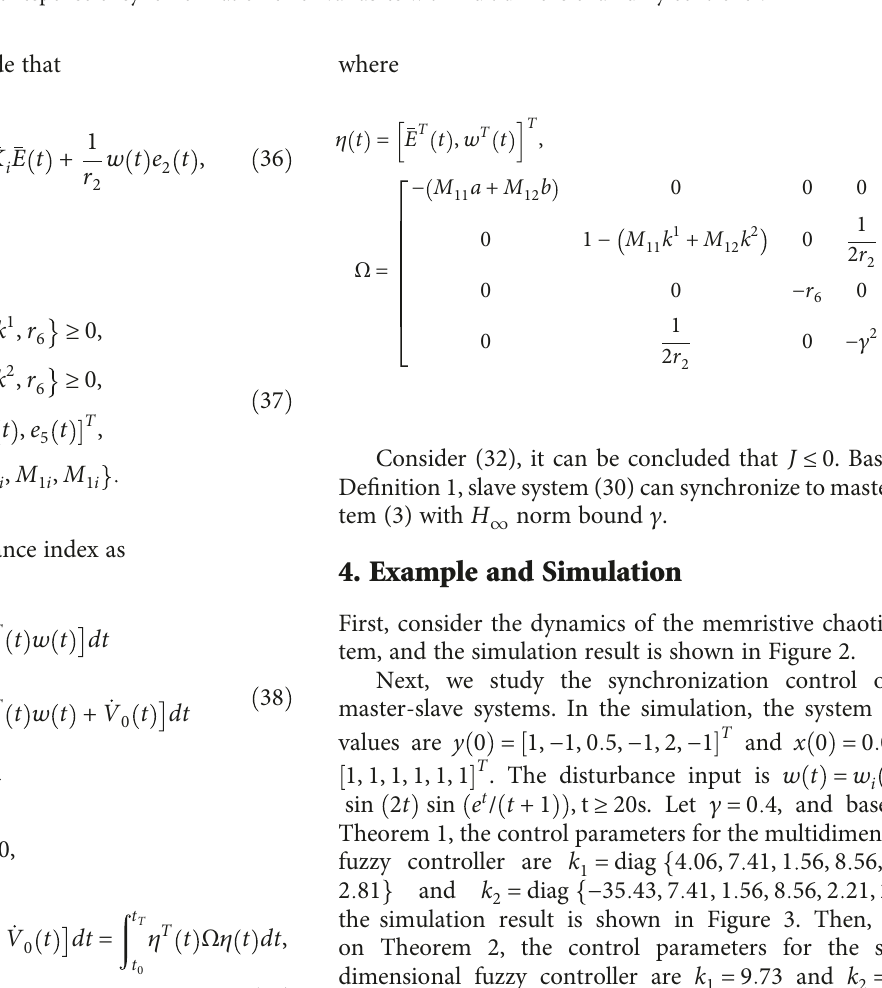
Figure 3: Time response of synchronization error variables with multidimensional fuzzy